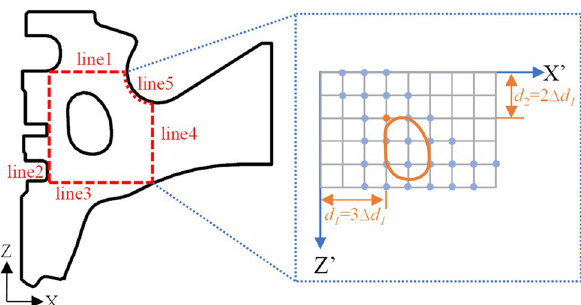
Figure 7. The structure and position parameters of the cooling